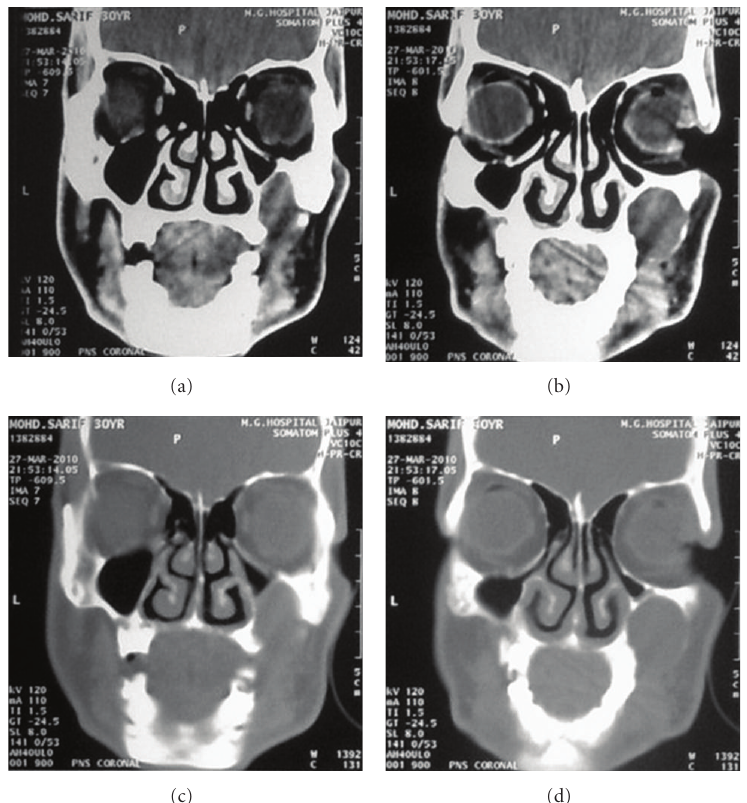
Figure 8: (a, b) CT scan view (coronal section soft tissue window), (c, d) CT scan view (coronal section bone window). Both views show a well defined soft tissue lesion causing displacement of inferolateral wall of the right sinus without involving